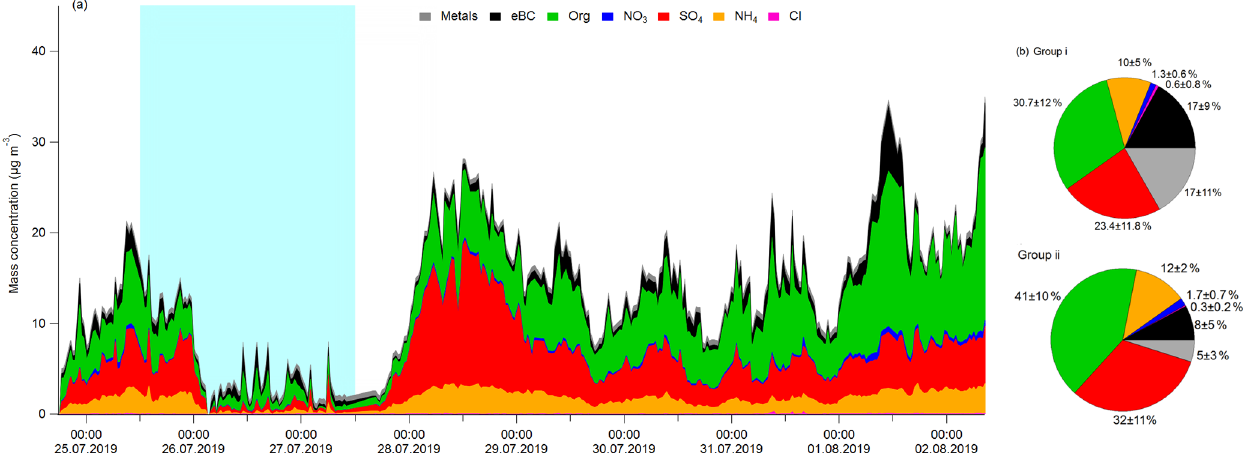
Figure 2. (a) Concentrations of non-refractory chemical components plus eBC in Yokohama, Japan (24 July to 2 August 2019). The blue shaded area represents group i from the coast, and the remaining areas represent group ii from the mainland. (b) Average contribution fractions of different chemical components of groups i and